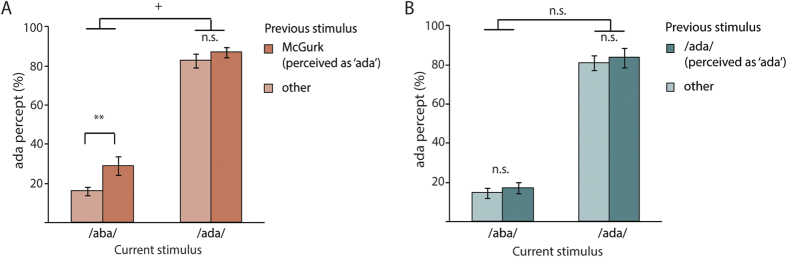
Behavioral results.(A) McGurk after-effect. More ‘ada’ percepts during auditory /aba/ stimuli preceded by fused McGurk stimuli (perceived as ‘ada’) compared to the other stimuli (auditory /aba/, /ada/, /aga/, audiovisual congruent /aba/, /aga/). (B) No perceptual priming. Perceiving ‘ada’ did not increase the probability of perceiving ‘ada’ on the next trial. Other stimuli refer to the remaining auditory stimuli, i.e. /aba/ and /aga/. (n.s. non-significant, +p < 0.1,*p < 0.05; **p < 0.01).